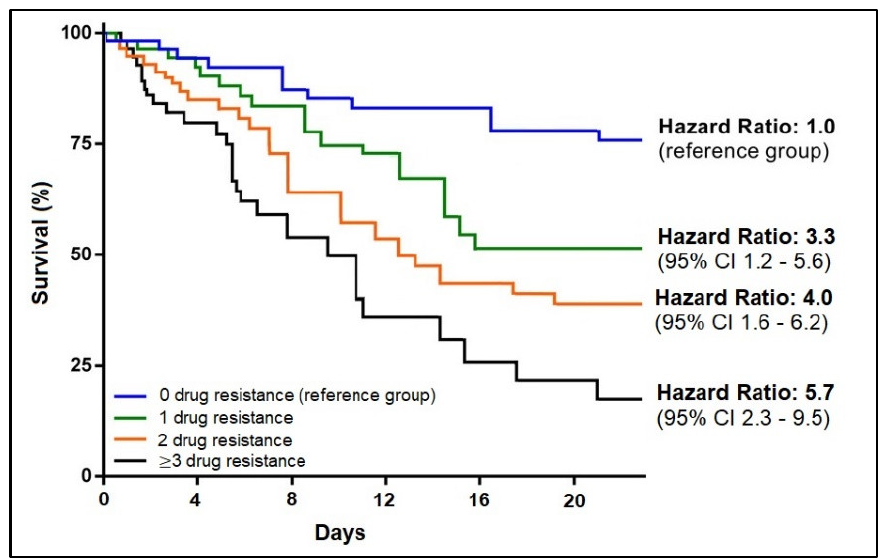
Figure 4. Kaplan–Meier probability curve for mortality by number of antimicrobial resistance. A matrix with the pattern of antimicrobial resistance by etiology of infection is de- scribed in Table 5. It was observed that Gram-negative pathogens involved in IE were 37.9% resistant to three or more specific antimicrobials, while 20.7% were sensitive to all specific antibiotics. In the Gram-positive group of infections, where S. aureus was the most prevalent pathogen, the multi-resistant strains to three or more specific antibiotics were present in 11.2% of patients, while 27.4% of all pathogens showed similar resistance patterns. By source of infection, it was observed that the most frequent etiology of IE with pathogens resistant to three or more specific antimicrobials were peripheral catheters, followed by cardiac surgery and dental and ENT interventions (Figure 5). Table 5. Antimicrobial resistance pattern by etiology of